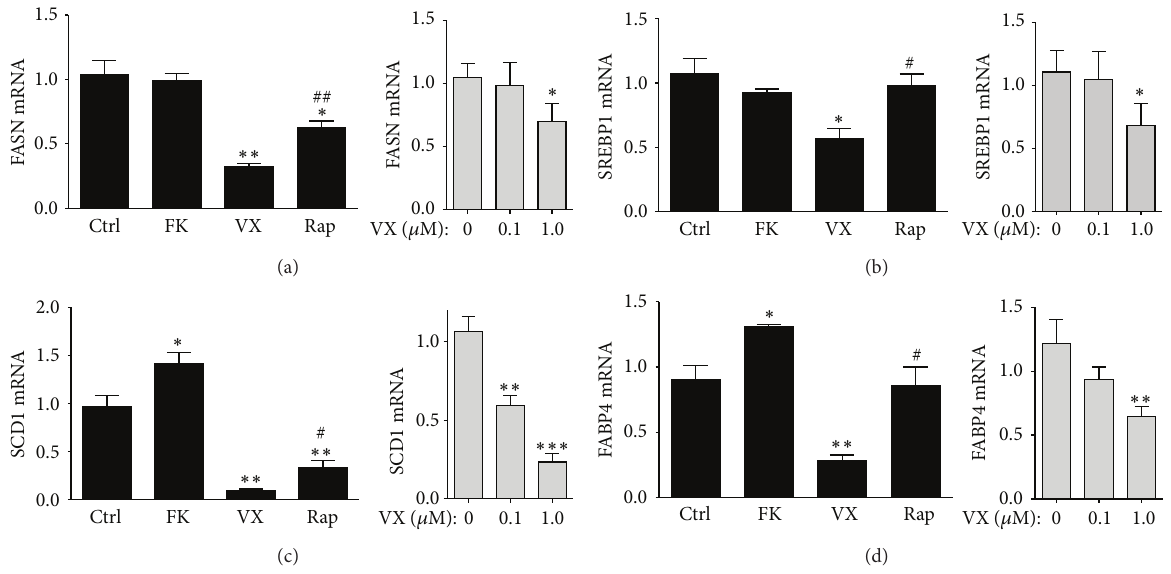
Figure 5: Genes involved in lipid accumulation are suppressed by timcodar. Real-time PCR analysis of differentiated 3T3-L1 adipocytes treated with vehicle (Ctrl), 1 𝜇 M FK506 (FK), 1 𝜇 M timcodar (VX), and 1 𝜇 M rapamycin (Rap), as well as a dose-dependent increase of timcodar for treatments of 0 𝜇 M, 0.1 𝜇 M, or 1.0 𝜇 M in gray boxes. (a) FASN, (b) SREBP1, (c) SCD1, and (d) FABP4. ∗ 𝑝 < 0.05 ; ∗∗ 𝑝 < 0.01 ; ∗∗∗ 𝑝 < 0.001 (versus control); # 𝑝 < 0.05 ; and ## 𝑝 < 0.01 (timcodar versus rapamycin treatment) ( ± S.E.; 𝑛 = 3